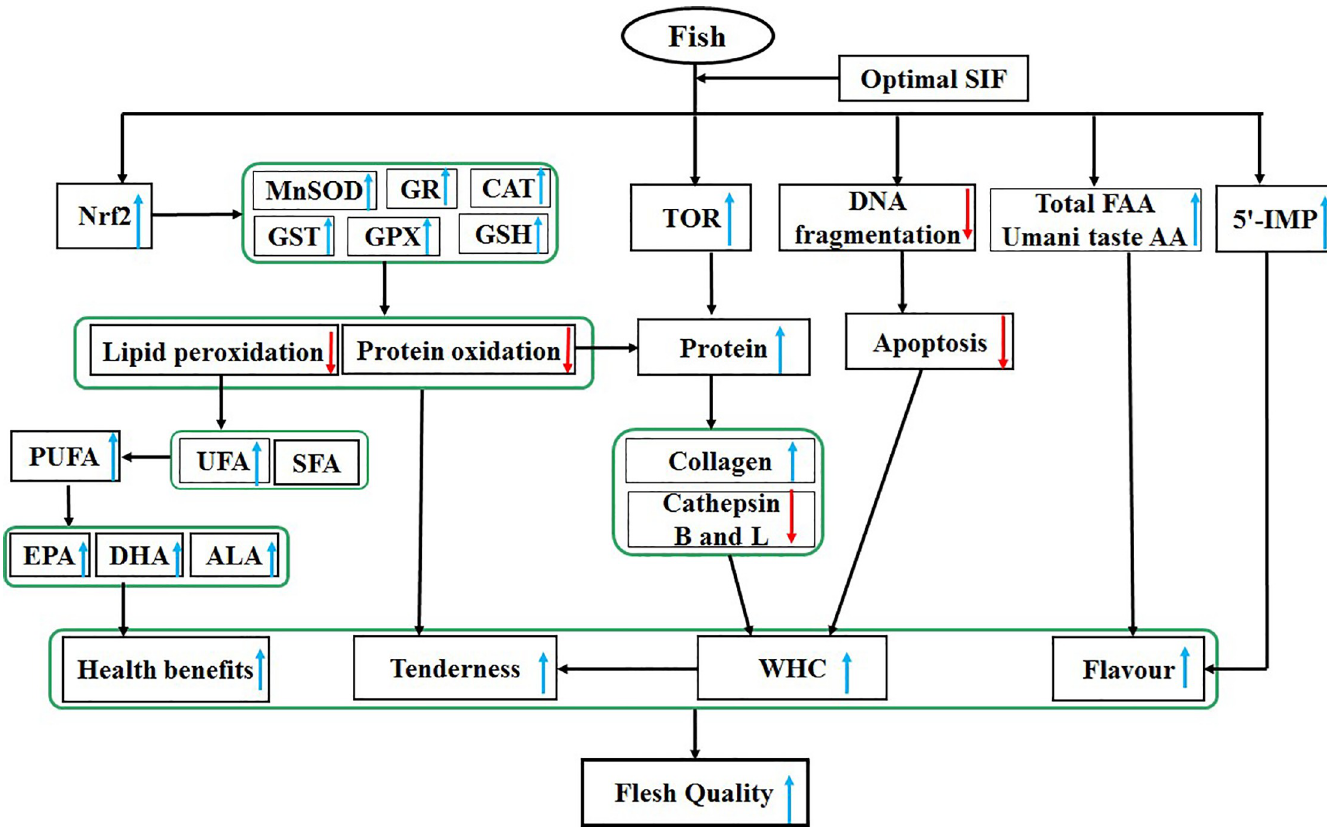
Fig 5. General summary for the effects of dietary SIF on meat quality and its potential signaling pathways in the muscle of fish. WHC, water-holding capacity; Nrf2, NF-E2-related factor 2; 5’-IMP, 5’-inosine monophosphate; FAA, free amino acids; TOR, target of rapamycin.